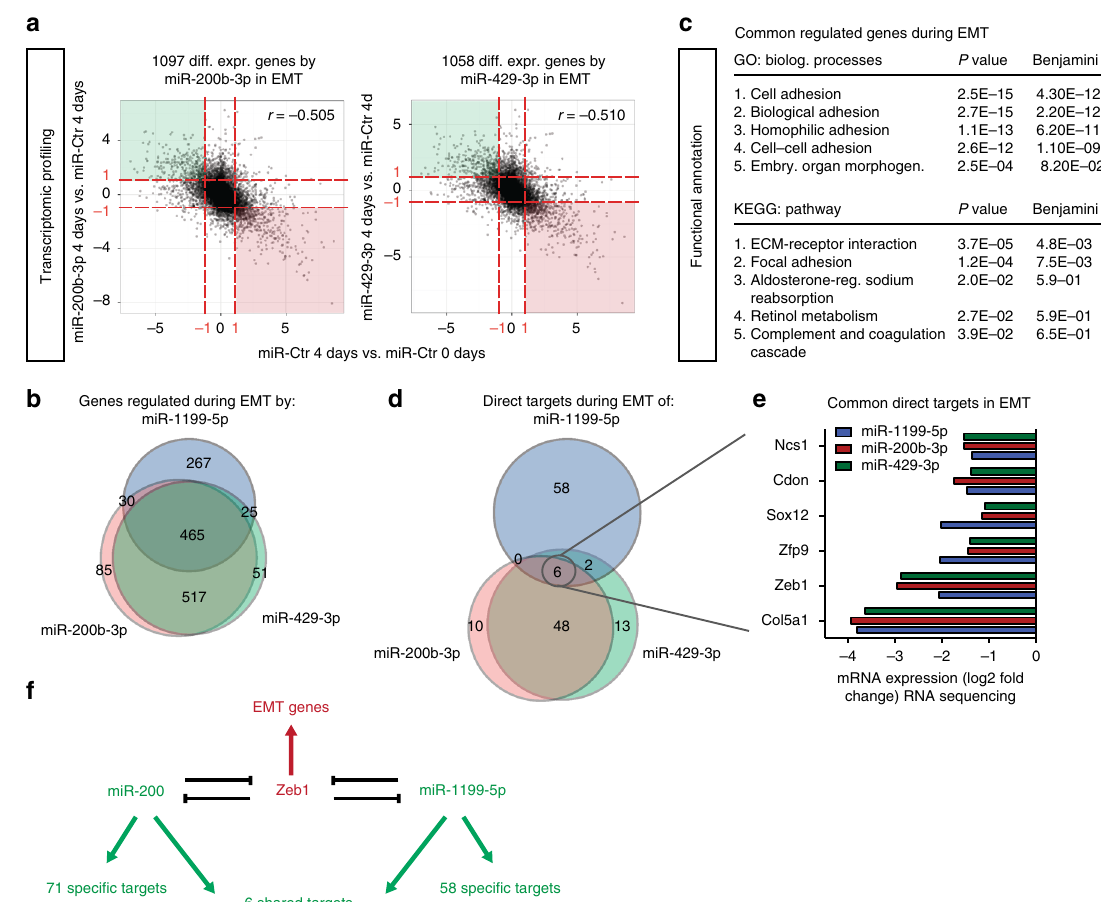
Fig. 7 Shared and distinct target genes of miR-1199-5p, miR-200b-3p and miR-429-3p. a Overall gene expression regulation by miR-200b-3p and miR-429- 3p during a TGF β -induced EMT. RNA-sequencing analyses were performed on NMuMG/E9 cells transiently transfected with a miR-200b-3p, miR-429-3p or a negative control (miR-Ctr) mimic. Cells were then cultured in the presence or absence of TGF β (0 day vs. 4 days). RNA sequencing and data analysis was performed as described for miR-1199-5p in Fig. 3a. Scatterplots depict the overall gene expression (log2FC) (anti-)correlation between miR-200b-3p 4 days vs. miR-Ctr 4 days (left) or miR-429-3p 4 days vs. miR-Ctr 4 days (right) over miR-Ctr 4 days vs. miR-Ctr 0 day. Differential expression analysis (red dashed line: log2FC( ± 1); FDR < 0.05) identi fi ed 1097 genes and 1058 genes regulated during an EMT by miR-200b-3p and miR-429-3p, respectively. b The Venn diagram summarizes the number of genes commonly and individually regulated by miR-1199-5p (blue), miR-200b-3p (red) and miR-429-3p (green) during a TGF β -induced EMT (data from Fig. 7a, Fig. 3a). c Functional annotation clustering analysis by DAVID of genes commonly regulated by miR-1199-5p, miR-200b-3p and miR-429-3p during an EMT. Presented are the top fi ve biological processes, pathways (KEGG) and their associated P and Benjamini – Hochberg values. d The Venn diagram presents the number of commonly and individually regulated, predicted target genes of miR-1199-5p (blue), miR-200b-3p (red) and miR-429-3p (green) during an EMT. MirWalk2.0 was used to predict miRNA target genes that show reduced transcript